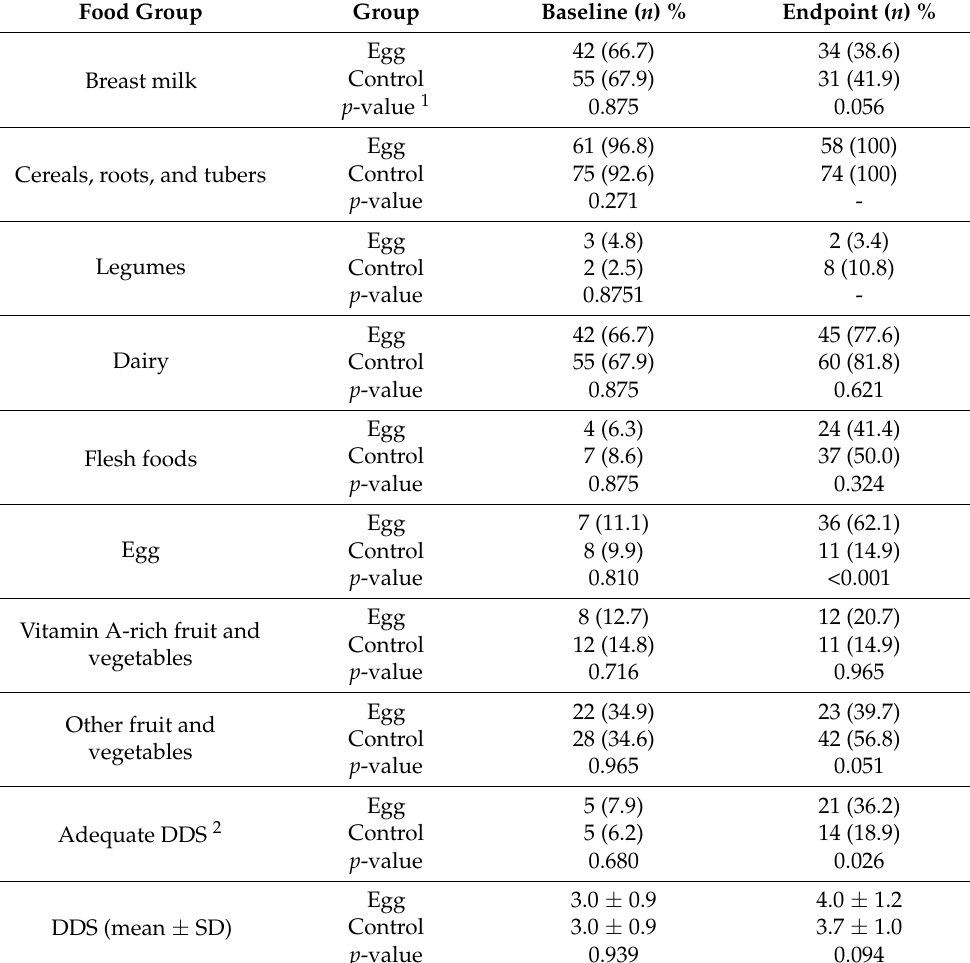
Table 4. Proportion of babies who consumed any foods from the eight foods groups during the 24-h recall period at baseline and endpoint.